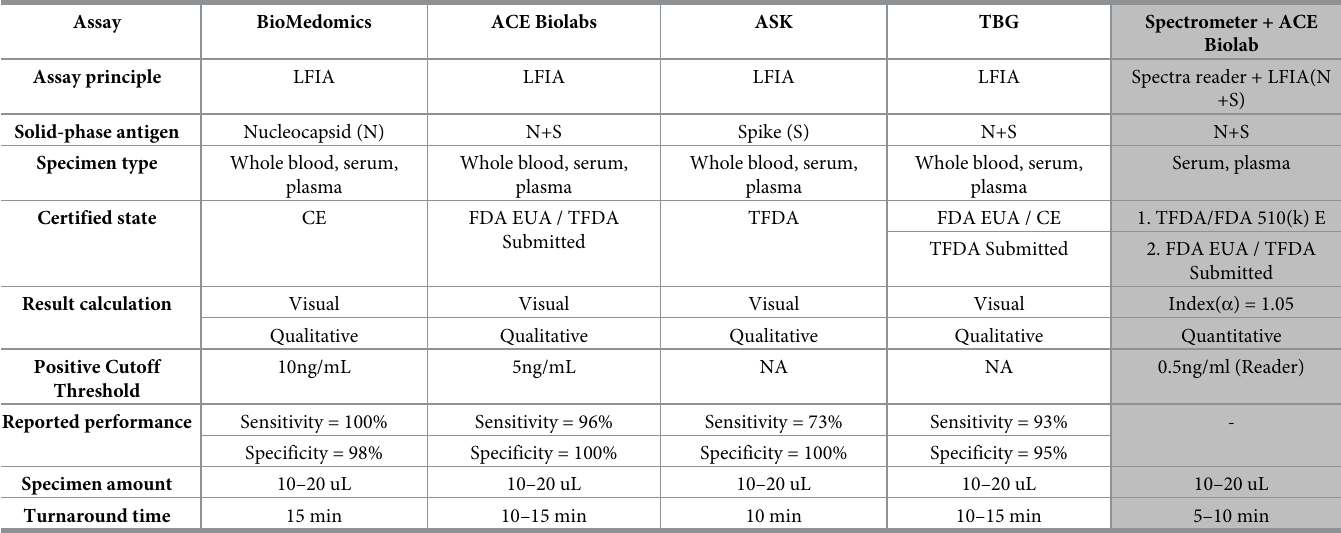
Table 2. Lateral flow immunoassays for COVID-19 diagnostic testing.